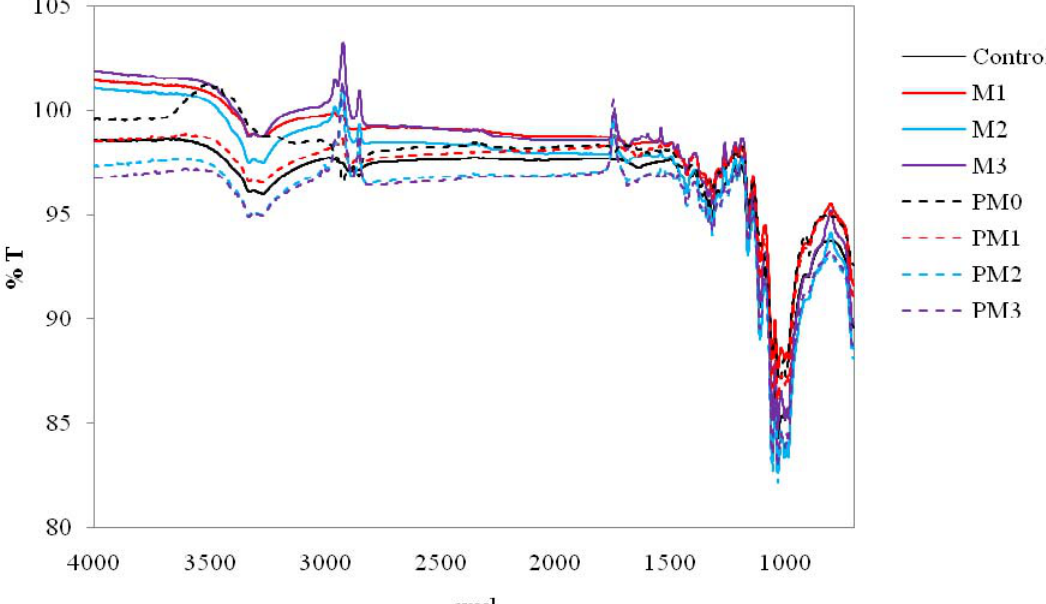
Figure 4. FTIR spectra of anti-microbial treated cotton specimen at 4000 to 700 cm − 1